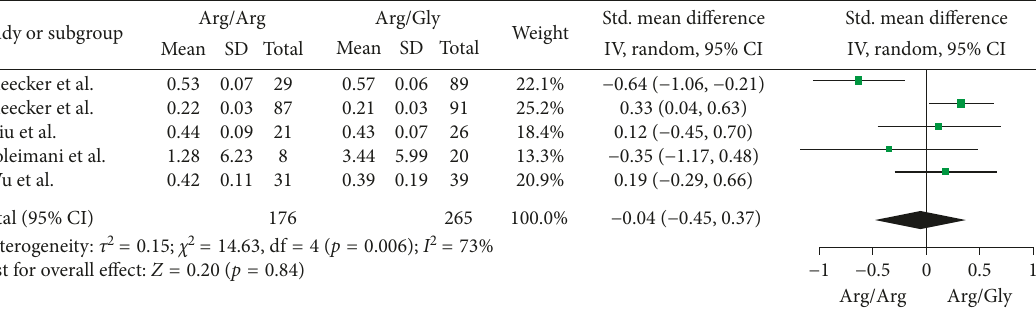
Figure 3: Forest plots of the association between the ADRB2 Arg16Gly polymorphism and pulmonary function response of inhaled ICS plus LABAs for asthma treatment (Arg/Arg or Arg/Gly) with 5 studies included.